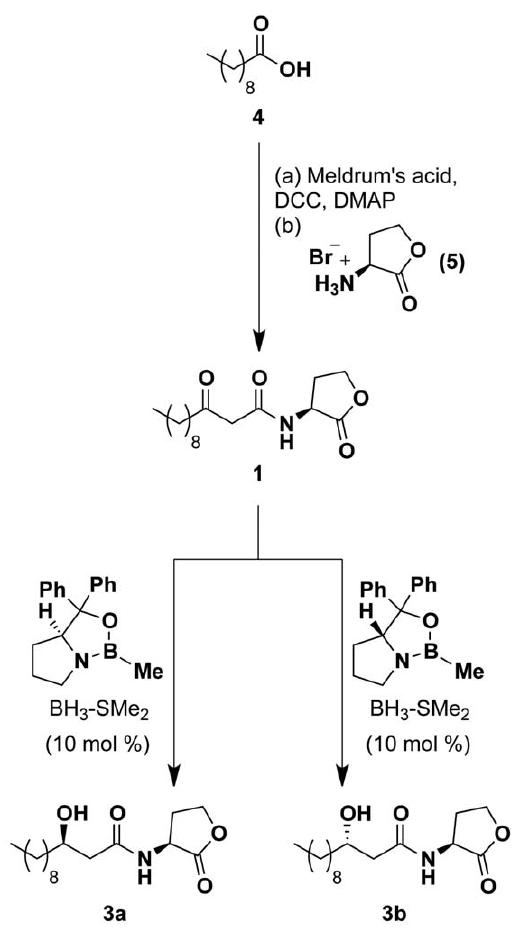
Figure 2. Synthesis of ( R )-3-OH-C 12 - L -HSL (3a) and ( S )-3-OH-C 12 - L -HSL (3b).